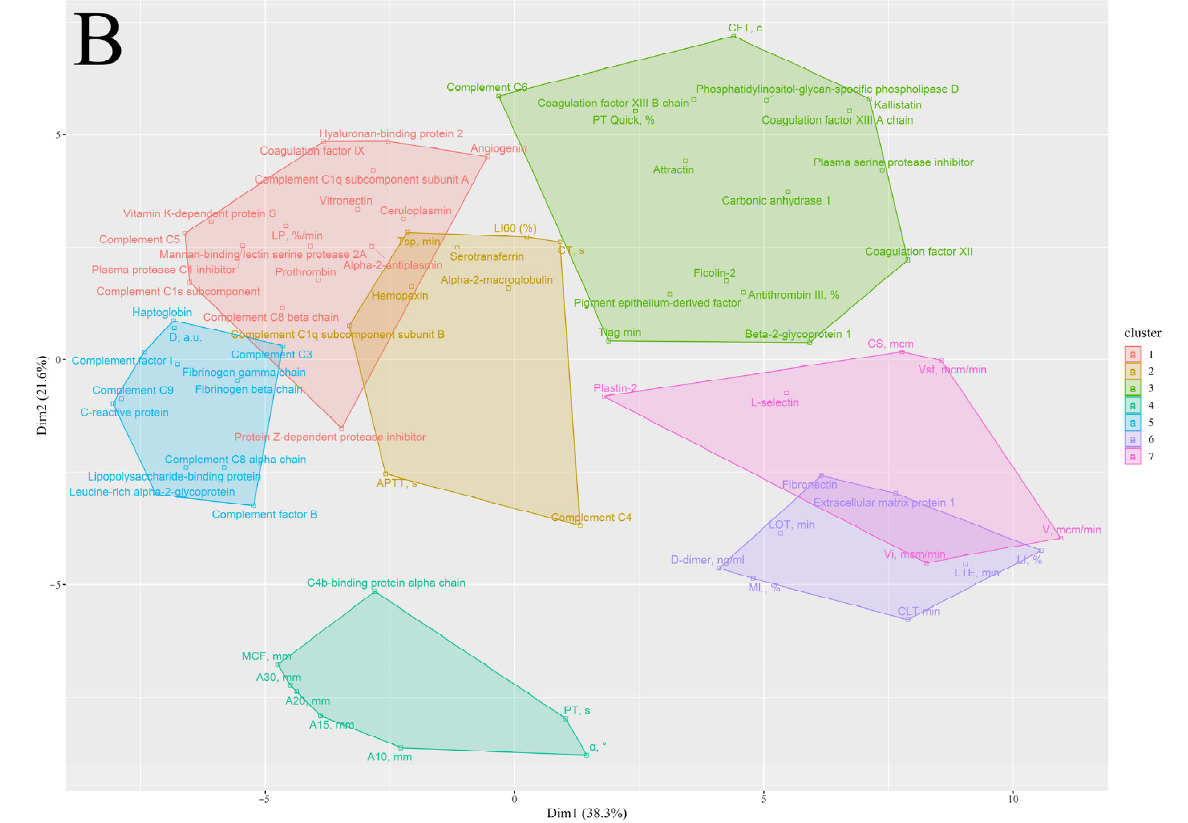
Figure 3. Clusterization of parameters of hemostasis, and proteins involved in inflammation and hemostasis, components of the complement system, and two proteins affecting the endothelium (angiogenin, PEDF). We performed clusterization using the k-medoids algorithm and a correlation matrix used as a matrix of distance. For defining the number of clusters, we used gap statistics via bootstrapping with Monte Carlo simulation and different centroids. Parameters of coagulation